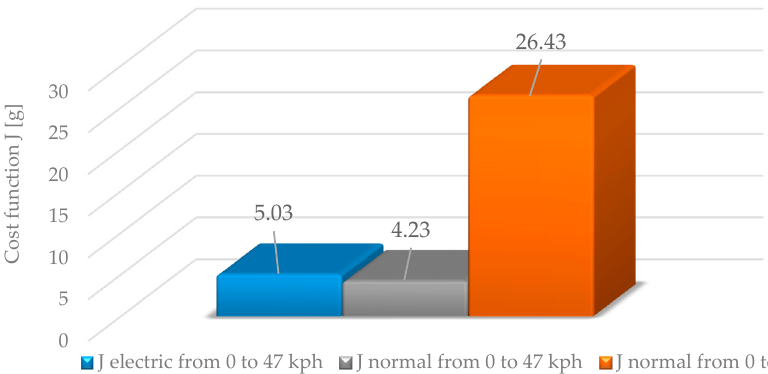
Figure 8. Cost function during acceleration of the vehicle in electric and normal modes (from 0 to 47 km/h and from 0 to 90 km/h).